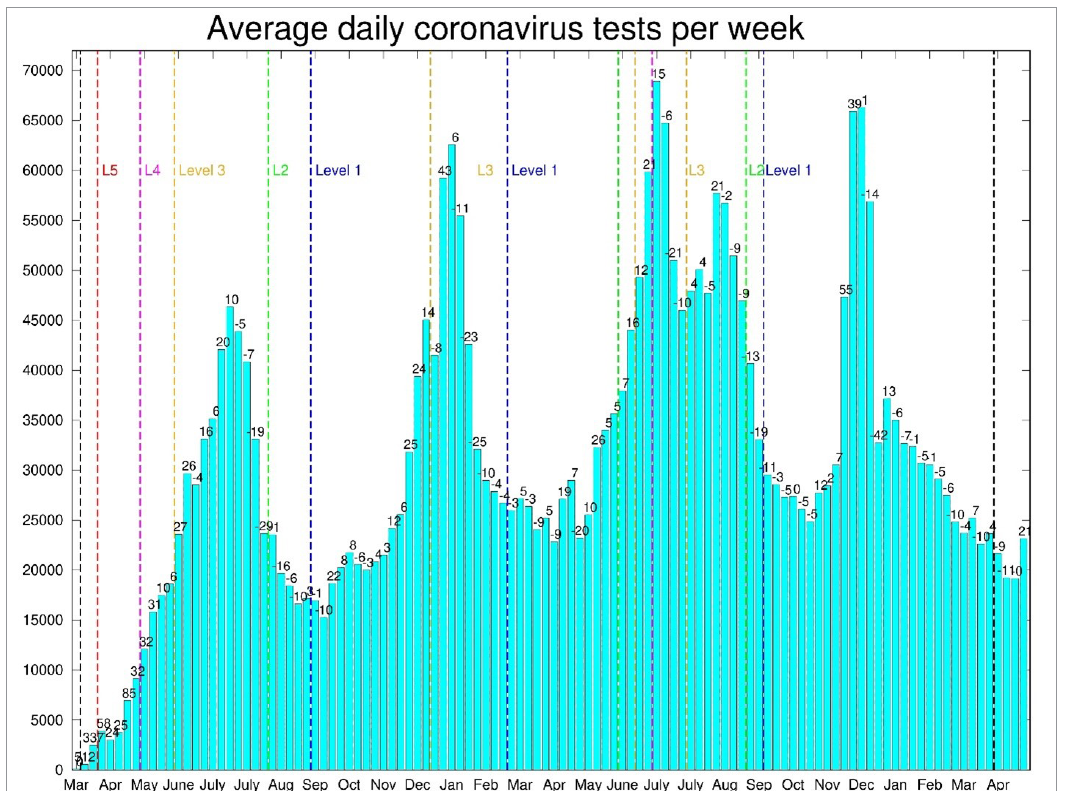
Figure 2: Average daily SARS-CoV-2 tests conducted in South Africa.